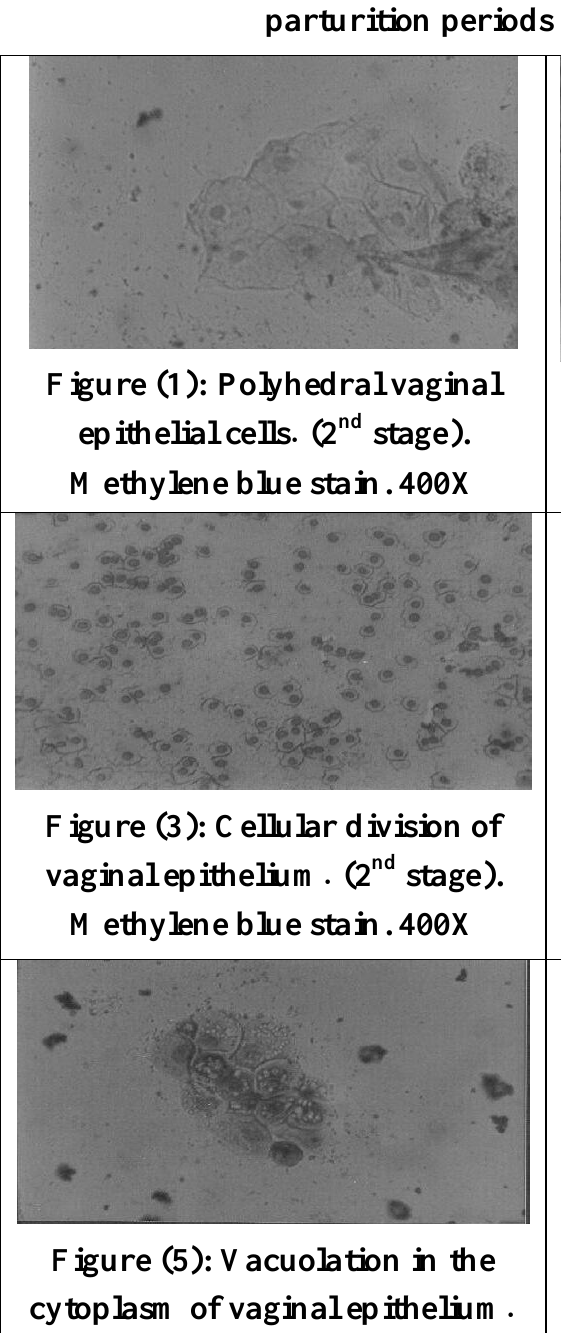
Figure (6): Vaginal epithelial cells Figure (5): Vacuolation in the with different sizes showing cytoplasm of vaginal epithelium . different affinities for staining. (3 rd stage). (3 rd stage). Methylene blue stain. 400X Methylene blue stain.